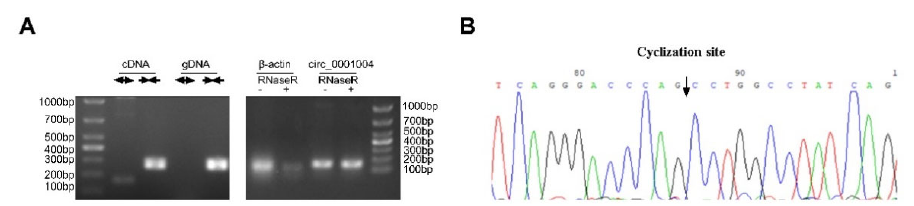
Figure 1. Characterization of rno_circ_0001004 in a GH 3 cell. ( A ) PCR analysis for